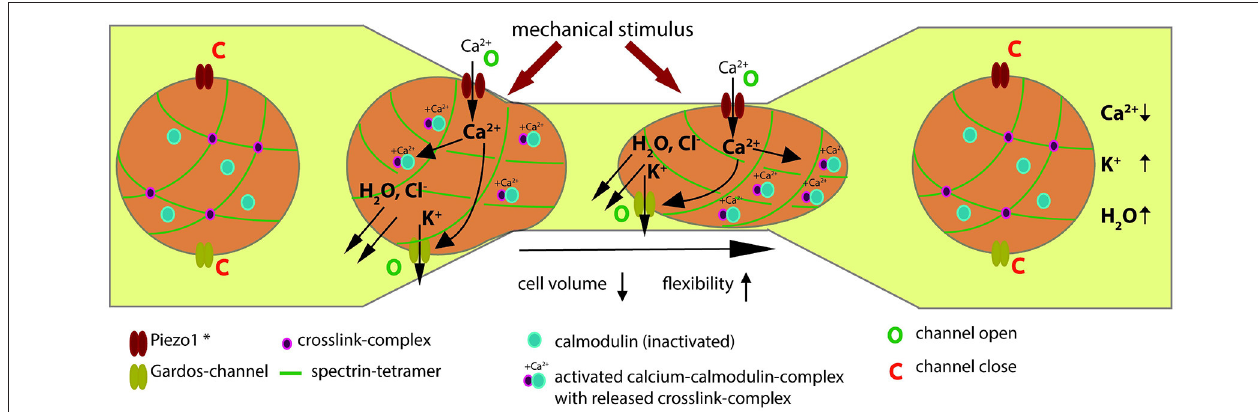
FIGURE 6 | Evidence based hypothesis of the Ca 2 + -signaling mechanism when RBCs pass capillaries. The description of a RBC passing through a constriction is described from left to right. Under laminar flow of RBCs in the vessel, for both Piezo1 and the Gardos-channel the open probability is very low and they can be regarded as being in a closed state (denoted by a “C” next to the channel symbols). *In this scheme Piezo1 denotes the most probably involved molecular player but could also be a different mechanosensitive mechanism. As the RBC enters a constriction and the cell comes in mechanical contact with the vessel wall, this mechanical stimulus activates Piezo1 (denoted by a “O” next to the channel symbol). Since Piezo1 is a non-selective cation-channel (Gottlieb and Sachs, 2012) and in view of the tremendous gradient for Ca 2 + across the membrane (Tiffert et al., 2003), Ca 2 + will enter the cell. This will activate the Gardos-channel (denoted by a “O” next to the channel symbol) and the calcium-calmodulin complex (Ca-CaM) will be formed (associated blue and pink circles). Activation of the Gardos-channel will result in loss of K + , Cl − and water, i.e., in cell shrinkage. The Ca-CaM destabilizes the actin—addusin—Band 4.1 complex and the cross-linked spectrin network becomes more flexible (interrupted green lines). For a more detailed description of this process see Discussion. Both processes facilitate the passage of the RBC trough the constriction. Both, Piezo1 and Gardos-channels are likely to inactivate and close (denoted by a “C” next to the channel symbols). Na + /K + -pump and Ca 2 + -pump (not shown in scheme) will restore the original ion concentrations and such the RBC volume will return to its original size. Likewise the Ca-CaM will inactivate resulting in the dissociation of the calmodolin (blue circles) and thus the cross-linking of the spectrin tetramers (pink circles at cross-section of green lines).